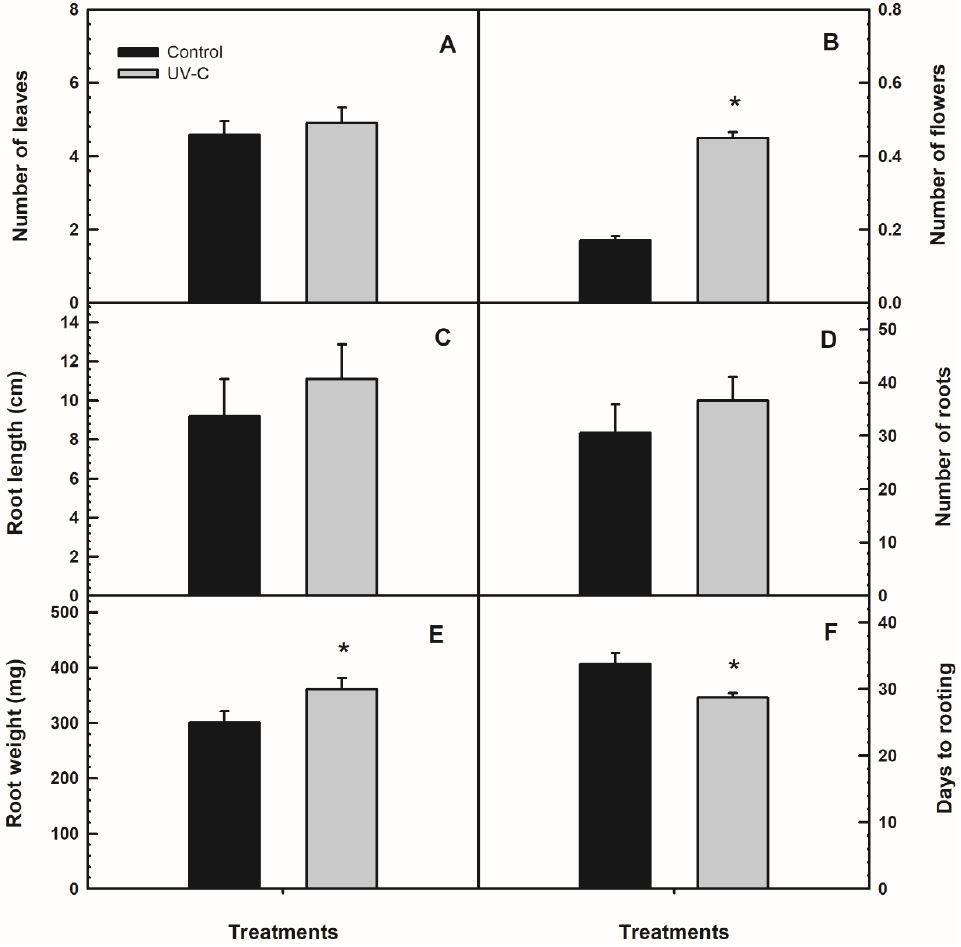
Figure 6. Number of leaves ( A ), number of flowers ( B ), root length (cm; C ), number of roots ( D ), root weight ( E ) and days to rooting ( F ) of P. × hortorum stem cuttings irradiated with 1 kJ m −2 or left nonirradiated (controls) for 6-week period. Data ( n = 30) were collected by the end of the experiment and are means per treatment per day ±S.E. Asterisks indicate significant differences between treatment means at p = 0.05.